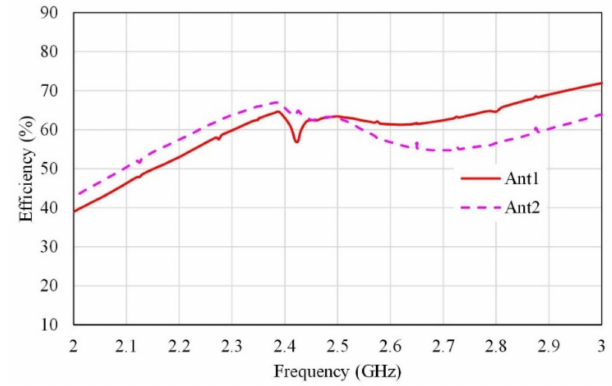
Figure 9. MIMO antenna radiation